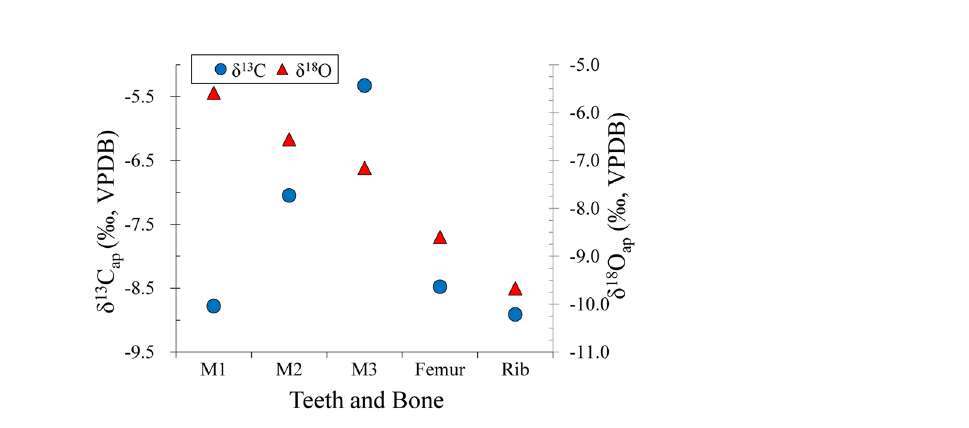
Figure 5. Scatter plot of δ 13 C and δ 18 O values from teeth enamel and bone